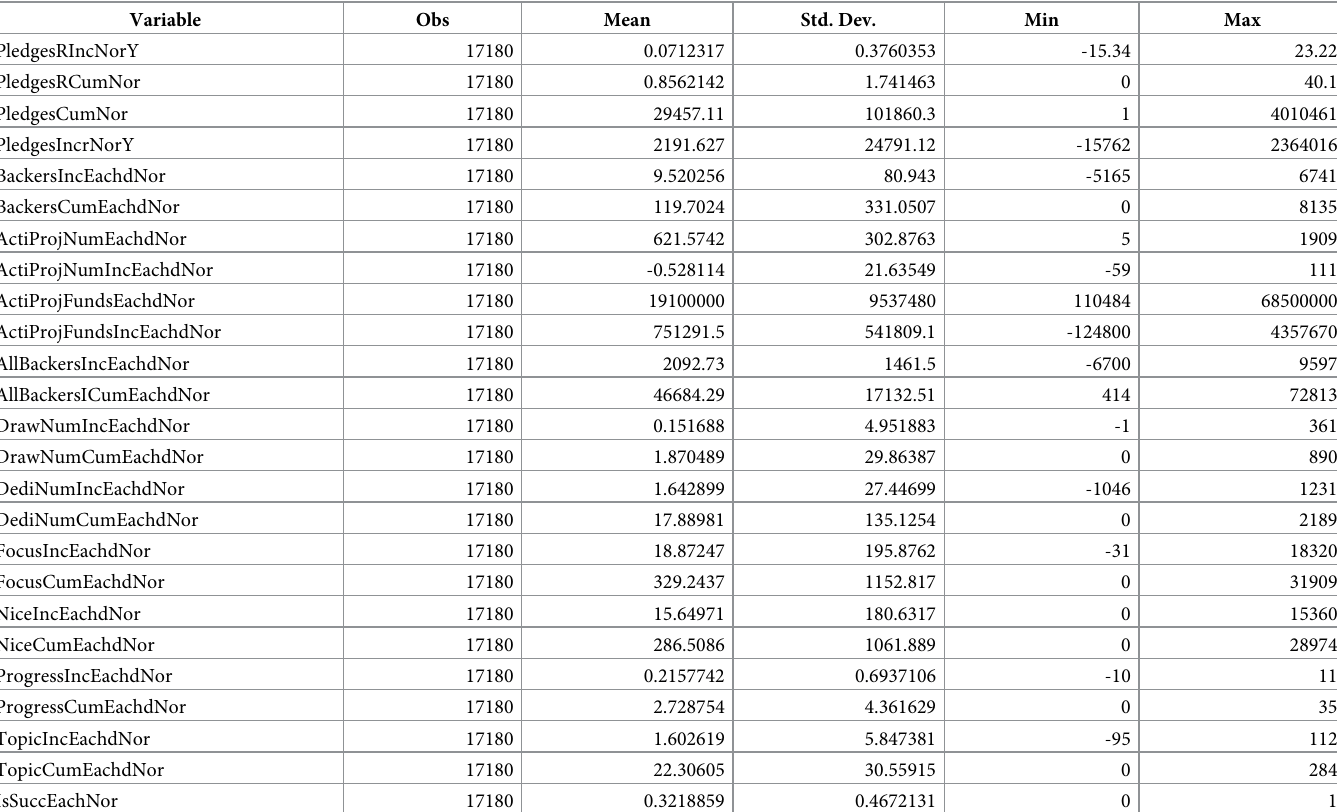
Table 2. Summary statistic of normalized